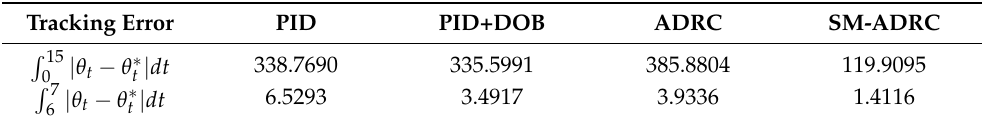
Figure 4. Simulation results with sinusoidal torque disturbance.